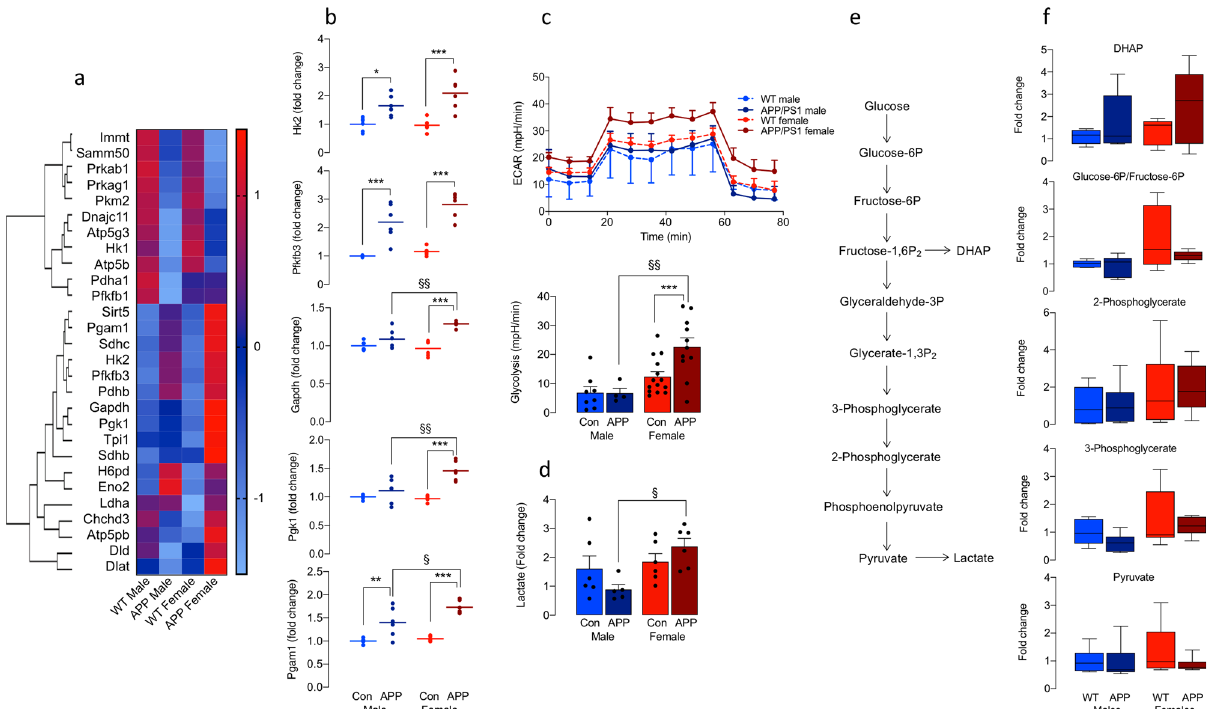
Fig. 4 Microglia from female APP/PS1 mice shift their metabolism towards glycolysis. a , b NanoString analysis indicated that Hk2, Pfkfb3, Gapdh, Pgk1 and Pgam1 were upregulated in cells from APP/PS1, compared with WT, mice (* p < 0.05; ** p < 0.01; *** p < 0.001; n = 6) with some changes signi fi cantly greater in female APP/PS1 mice compared with males ( § p < 0.05; §§ p < 0.01). Expression is displayed on a log 10 scale from blue (low expression) to red (high expression). c ECAR was increased in microglia from female APP/PS1 mice with a signi fi cant increase in glycolysis in microglia from female APP/PS1 ( n = 11), compared with female WT ( n = 14), mice (*** p < 0.001) and male APP/PS1 mice ( §§ p < 0.01; n = 4) and also male WT mice ( n = 8). d Lactate was increased in microglia from female APP/PS1 mice ( n = 6) compared with male APP/PS1 mice ( § p < 0.05; n = 5). e , f No genotype- or sex-related changes were observed in other intermediate metabolites of glycolysis ( n = 6 except for DHAP where n = 5). Minimal changes were observed in intermediate metabolites of the TCA (Supplementary Fig. 3) although marked sex-related differences were identi fi ed in amino acids generated from intermediate metabolites of glycolysis and the TCA (Supplementary Fig. 3). The changes in b , d and f are relative to values in WT males. Data, expressed as means ± SEM, were analysed by 2-way ANOVA and Tukey ’ s post hoc multiple comparison